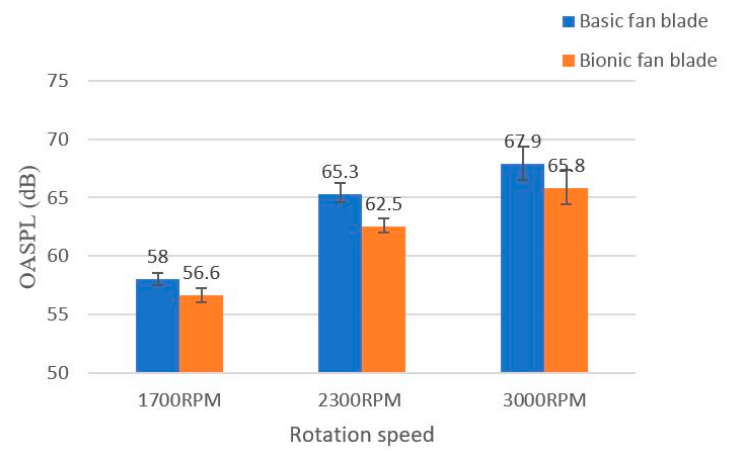
Figure 11. Overall sound pressure level of the basic fan blade and bionic fan blade at different rotational speeds.